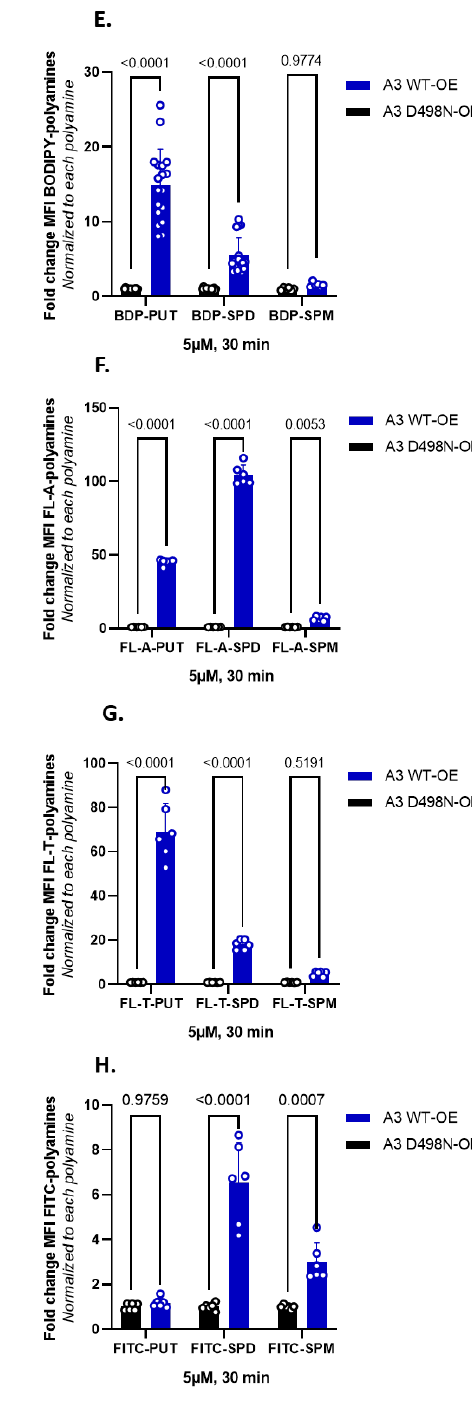
Figure 5. Comparison of the cellular uptake of BODIPY-conjugated versus BODIPY-FL-A, BODIPY- FL-T and FITC-conjugated polyamines in ATP13A2 and ATP13A3 cell models. ( A – D ). SH-SY5Y, ATP13A2, WT-OE and D508N-OE cells were incubated for 2 h with 5 µ M of each fluorescently labeled polyamine. ( E – H ). HMEC-1, ATP13A3, WT-OE and D498N-OE cells were incubated for 30 min with 5 µ M of each fluorescently labeled polyamine. The mean fluorescence intensity (MFI) was recorded using a BD Canto II flow cytometer based on the settings used for BODIPY-polyamines and normalized as indicated on the Y axis. Experiments were performed four independent times (N = 4) in ATP13A2 cell model and three independent times (N = 3) in ATP13A3 cell model, with technical duplicates. Statistical analysis was conducted using GraphPad Prism and a two-way ANOVA test with Sidak’s multiple comparison test.